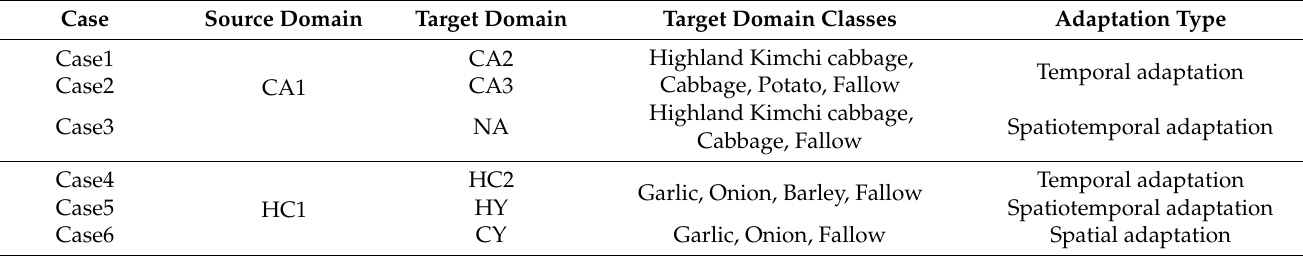
Table 2. The six domain adaptation cases considered in this